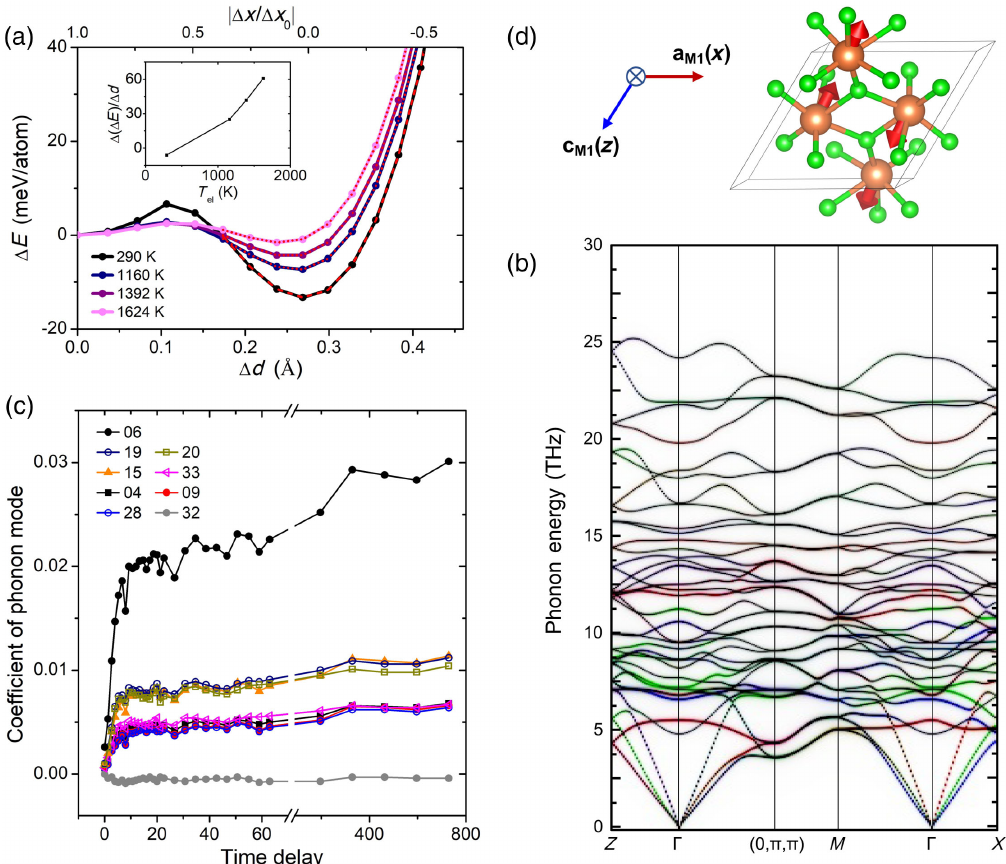
FIG. 4. DFT calculations of various phonon modes in VO 2 . (a) Potential energy surface as structure distorts from M1 to R phase at different T . Δ d is the difference between d ( d ) and the relaxed rutile V-V d ¼ 2 . 78 Å. Δ d ¼ 0 . 27 Å corresponds to the relaxed el short long M1 structure, and rutile structure is at Δ d ¼ 0 Å. Raising T lifts the energy of M1 structure and flattens the potential energy surface. el The potential energy surface flattening corresponds to the decreasing forces on atoms and the lowest energy structures transforming 290 K to T 1624 K, toward R phase. The dashed lines are fourth-order polynomial fit. Inset: the forces at d ¼ 0 . 27 Å from T el ¼ el ¼ corresponding to first-order derivative of polynomial fit of the potential energy surface. (b) The phonon dispersion of VO 2 , where the colors denote contributions from the V atomic vibration along the crystallographic a (red), b (green), and c (blue) directions. (c) Decomposition of the lattice displacement obtained in Fig. 3(a) into the nine A Raman phonon modes, drawn in Fig. S4 of g Supplemental Material [27]. (d) A schematic of phonon mode 6, which is found to be dominant in the structure transition. The Vand O atoms are orange and green balls, respectively. The red arrows represent V displacements. The length of arrows indicates the amplitude of displacement, which are scaled up by a factor of